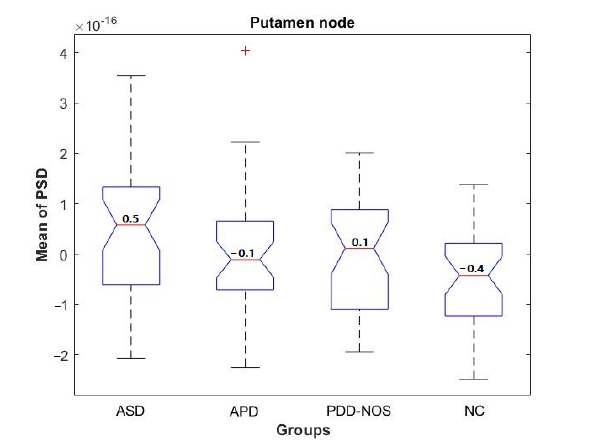
Figure 5. Statistical comparison of 3 ASD subtypes and NC based on PSD of putamen nodes.